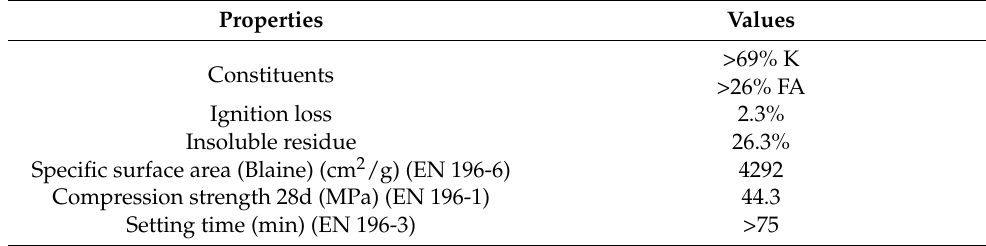
Table 2. Properties of Portland cement